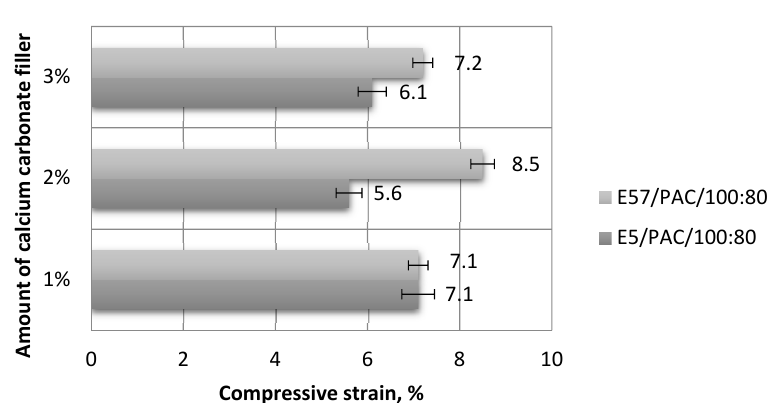
Figure 21. Comparison of the compressive strain between the E5/PAC/100:80 and E57/PAC/100:80 epoxy specimens modified by the calcium carbonate filler post-thermal shock chamber aging.